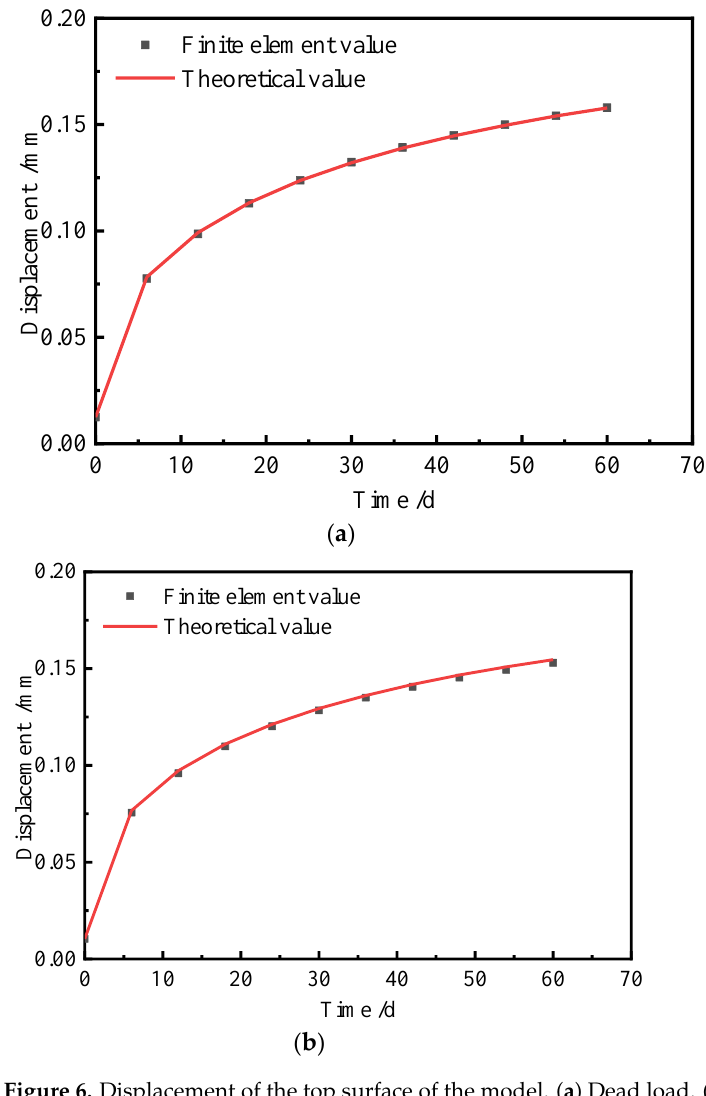
Figure 6. Displacement of the top surface of the model. ( a ) Dead load. ( b ) Time-dependent load.